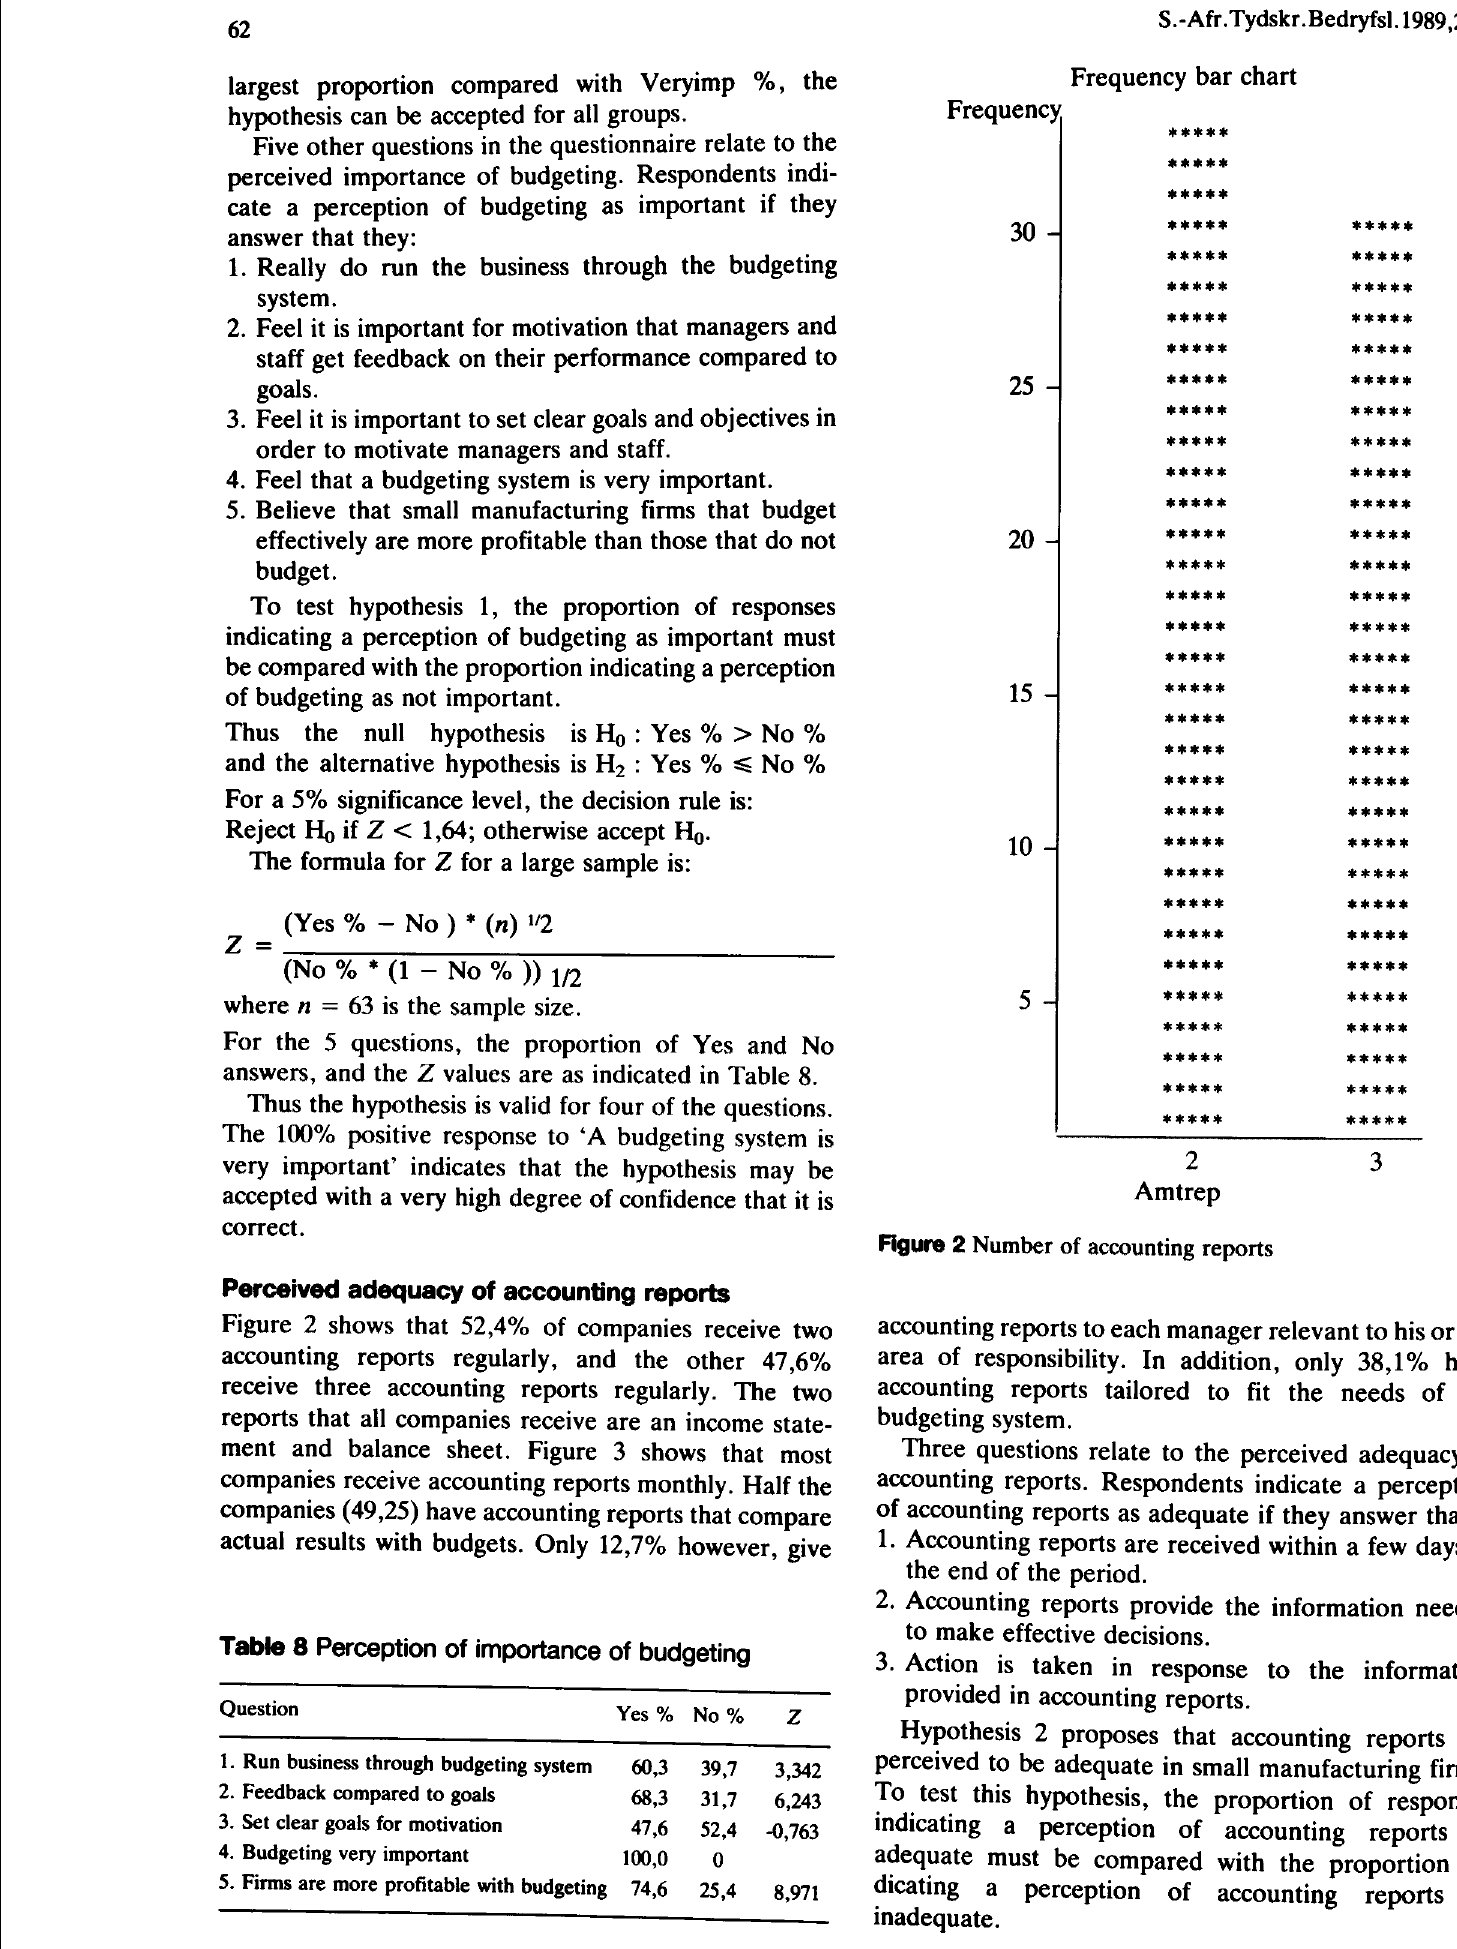
Table 8 Perception of importance of budgeting Question z 1. Run business through budgeting